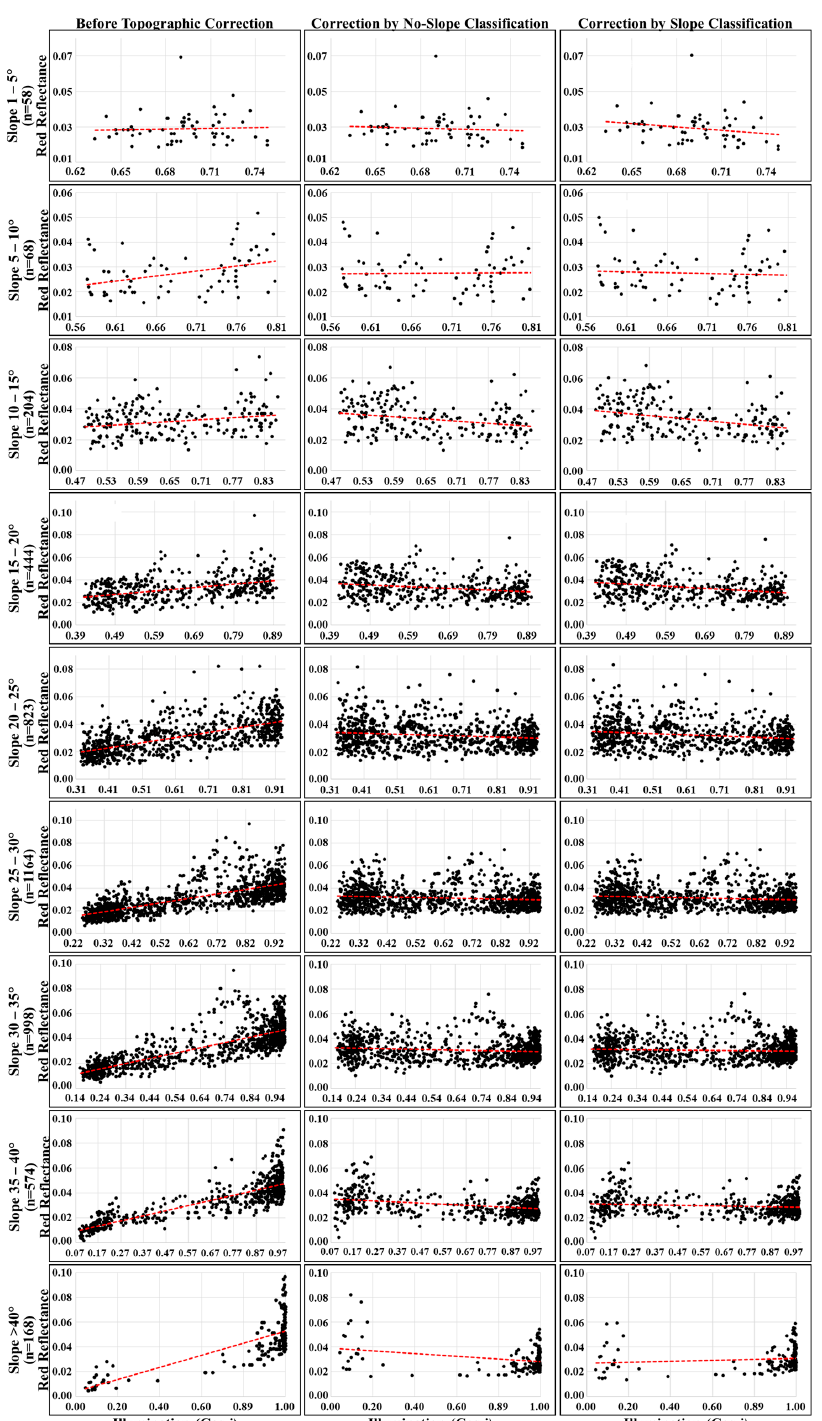
Figure 6. Scatterplots of forest area samples, before and after topographic corrections for each slope class. Image: Landsat TM from 2 December 2000.